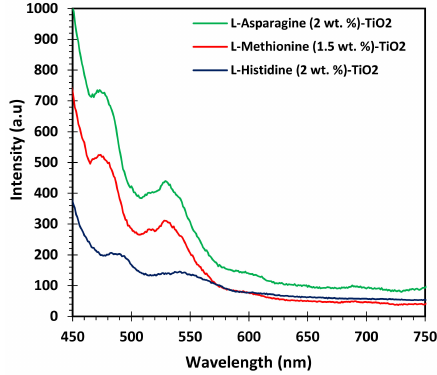
Figure 4. The PL analysis of the prepared